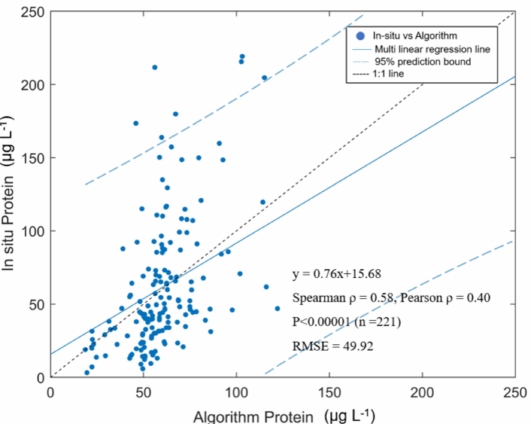
Figure 4. Linear relationship between the protein concentration of phytoplankton derived by the algorithm and field-measured data.